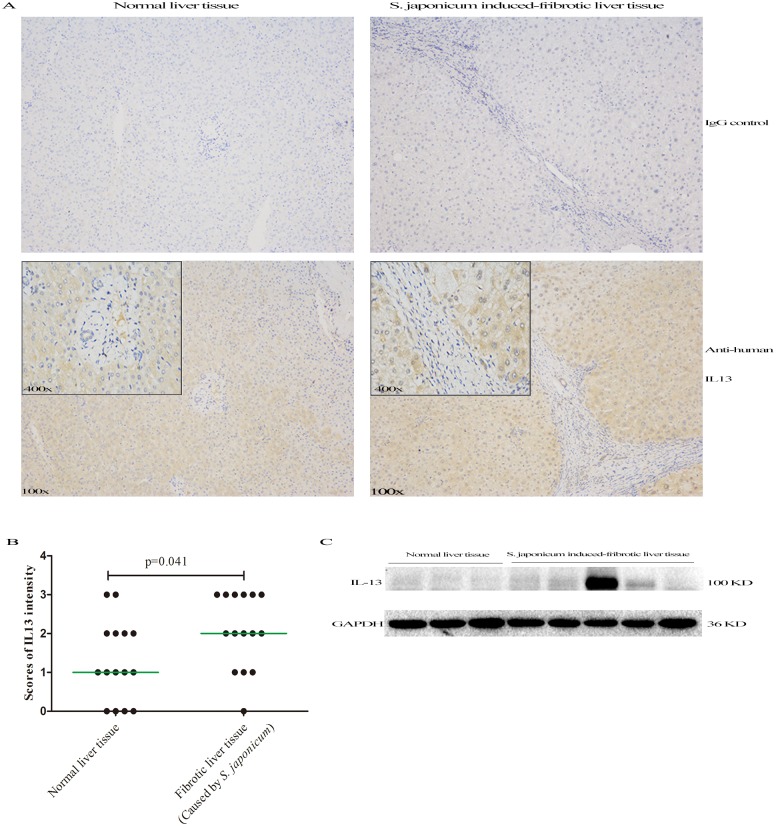
IL-13 protein was determined by IHC and western blot.(A) Representative images of normal liver tissues and S.japonicum-induced fibrotic liver tissues (Images were captured at 100x and 400x with scale bar of 100 μm). (B) Comparison of scores of ST2 staining intensity betwee S. japonicum-induced fibrotic liver tissues and normal liver tissues. (C) IL-13 protein was detected in liver tissue lysates by western blots.